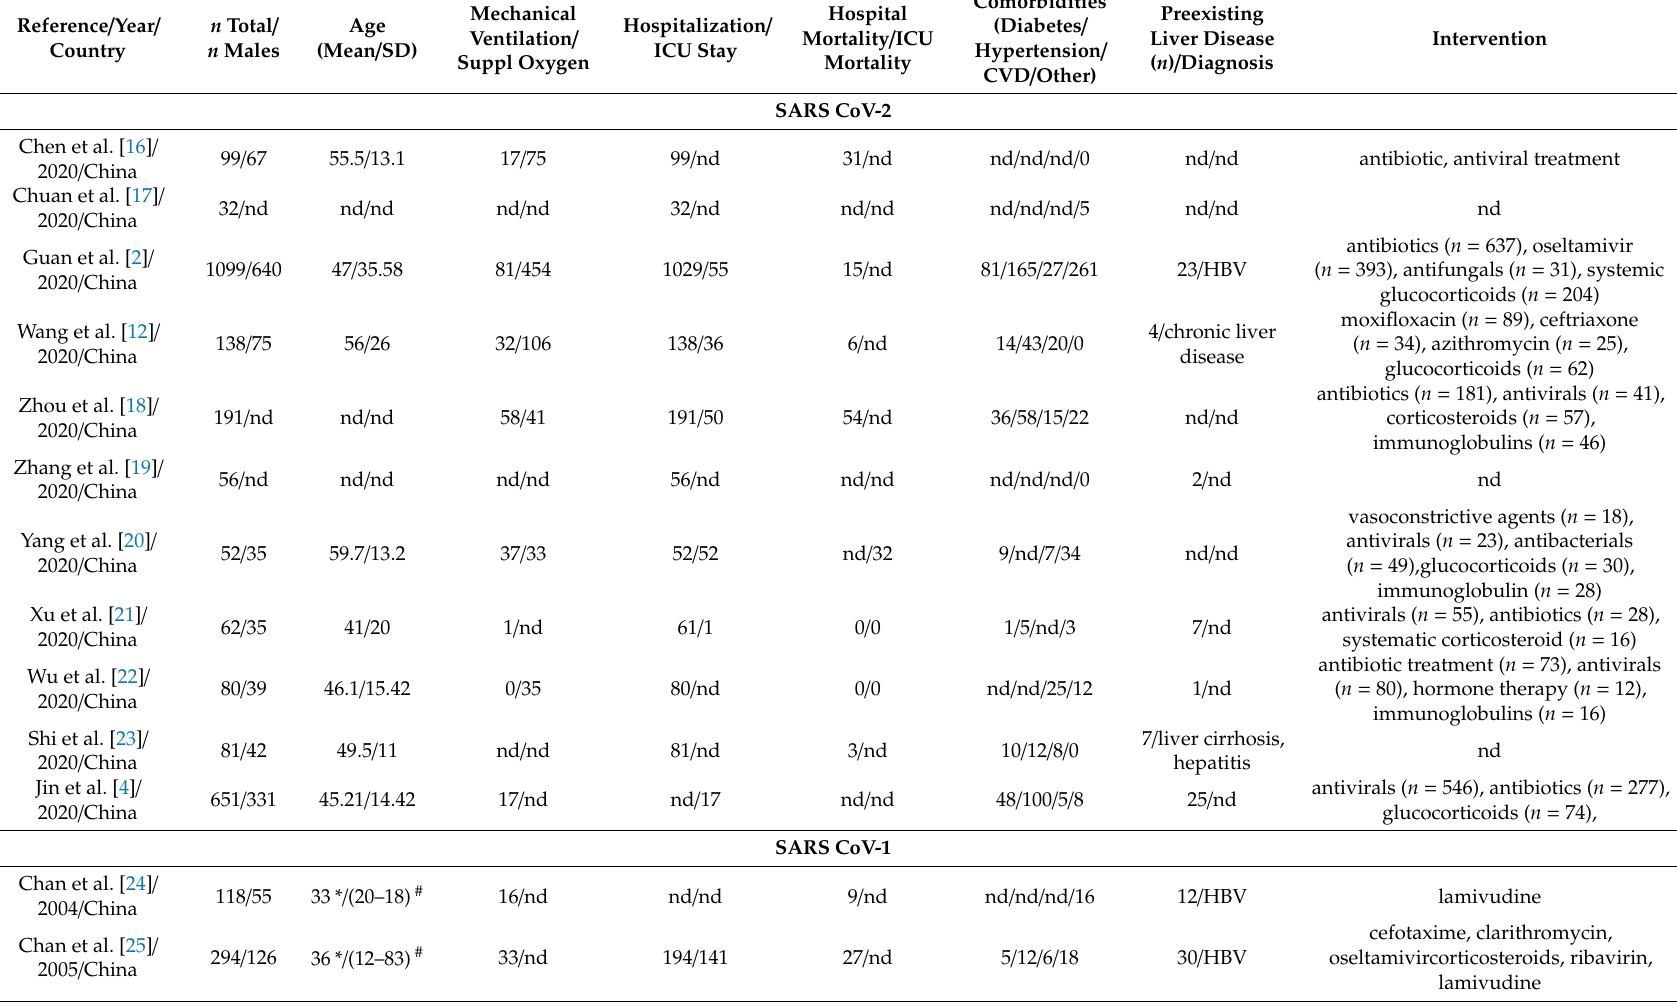
Table 1. Study and patient